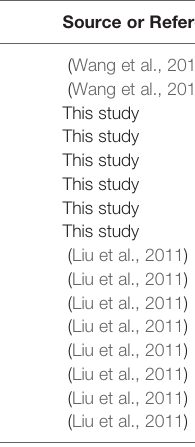
TABLE 1 | Primer sequences used for